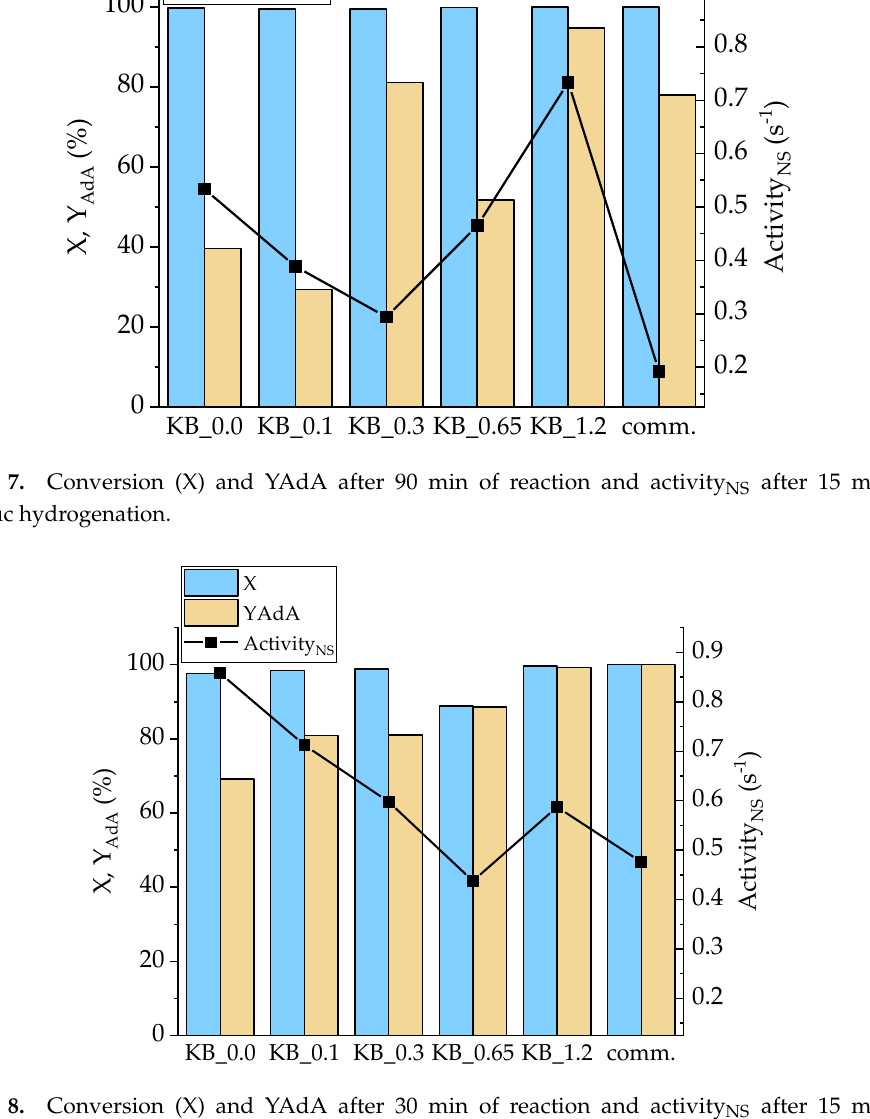
Figure 8. Conversion (X) and YAdA after 30 min of reaction and activity NS after 15 min for Na-Muc hydrogenation.